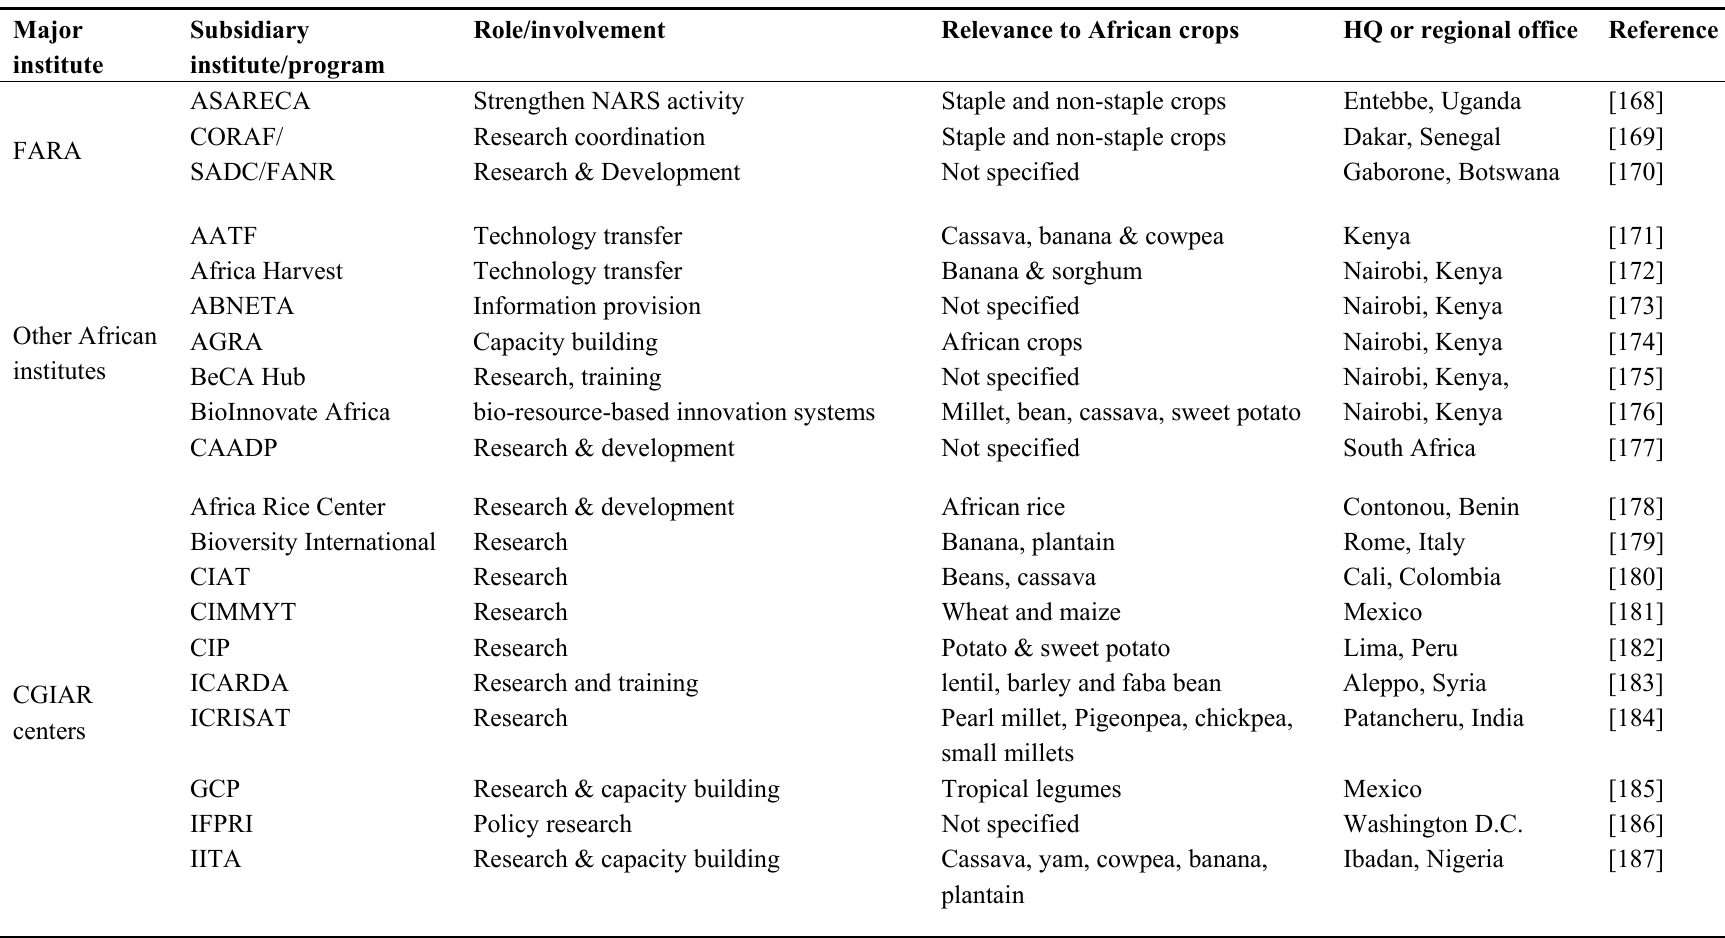
Table 3. Partial list of institutions involved in research and development of African crops. The list does not include national institutes. Information about national institutes involved in agricultural research and development is available on the Forum for Agricultural Research in Africa (FARA) website